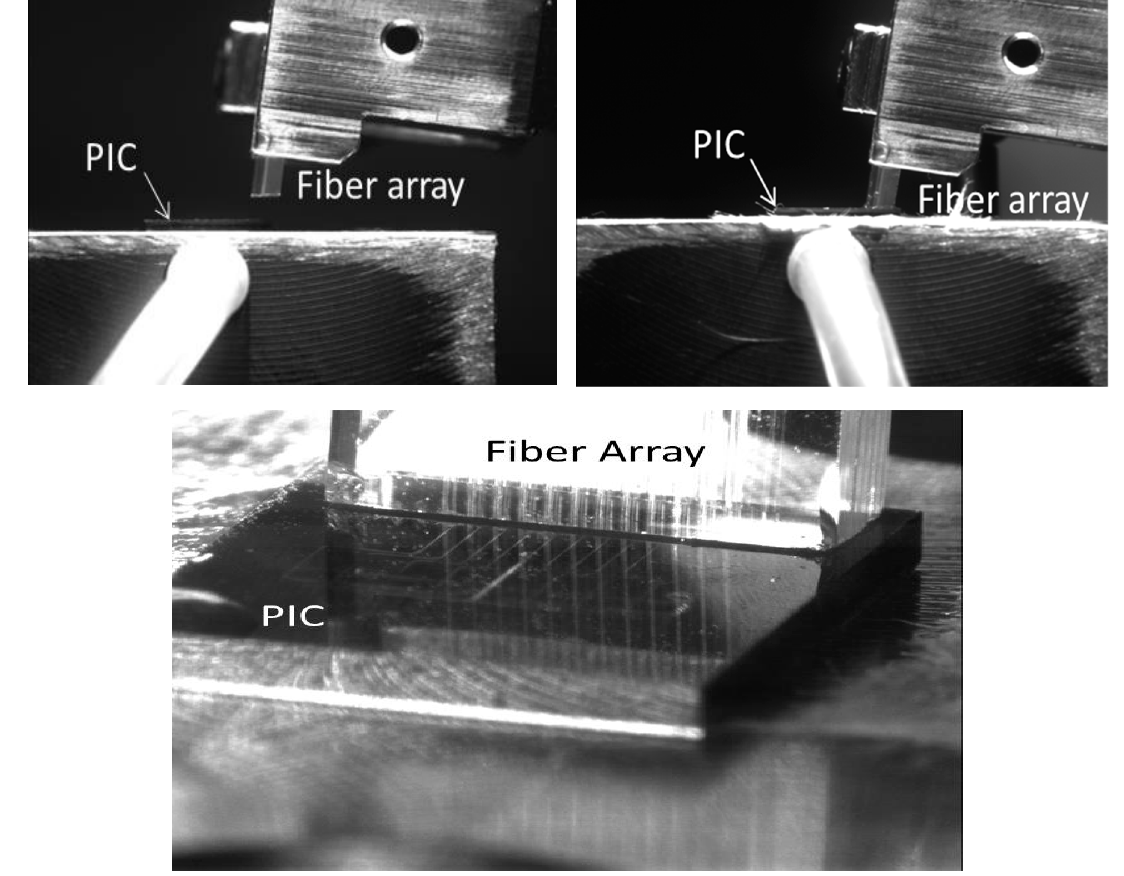
Figure 4. Biosensor fiber array attachment process.